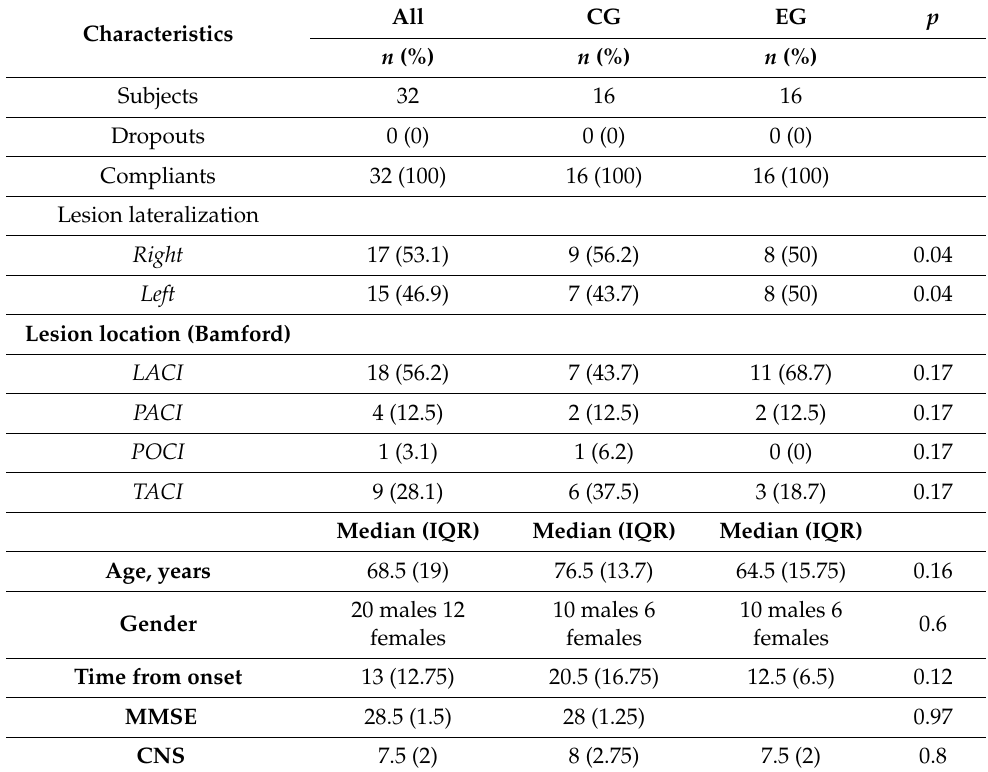
Table 1. Demographic and clinic characteristics of the sample at baseline (n =